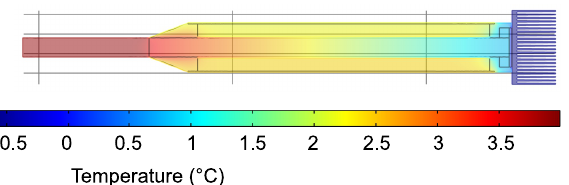
Figure 4. Model of the temperature distribution in the sensor. Red represents higher temperature, and blue represents lower temperature.